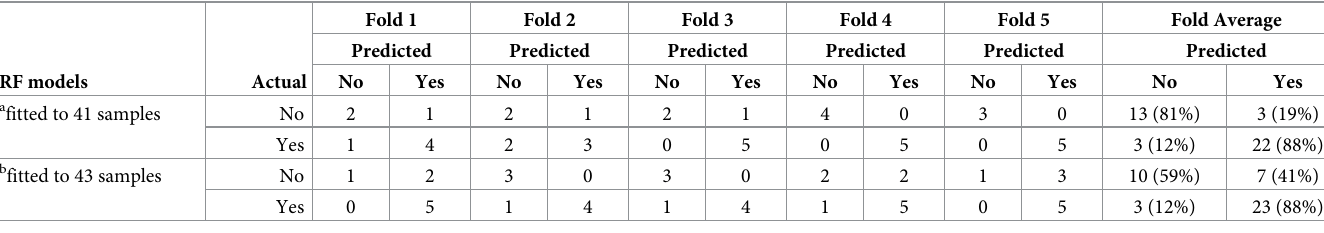
Table 1. Confusion matrices of each cross validation and average fold for random forest